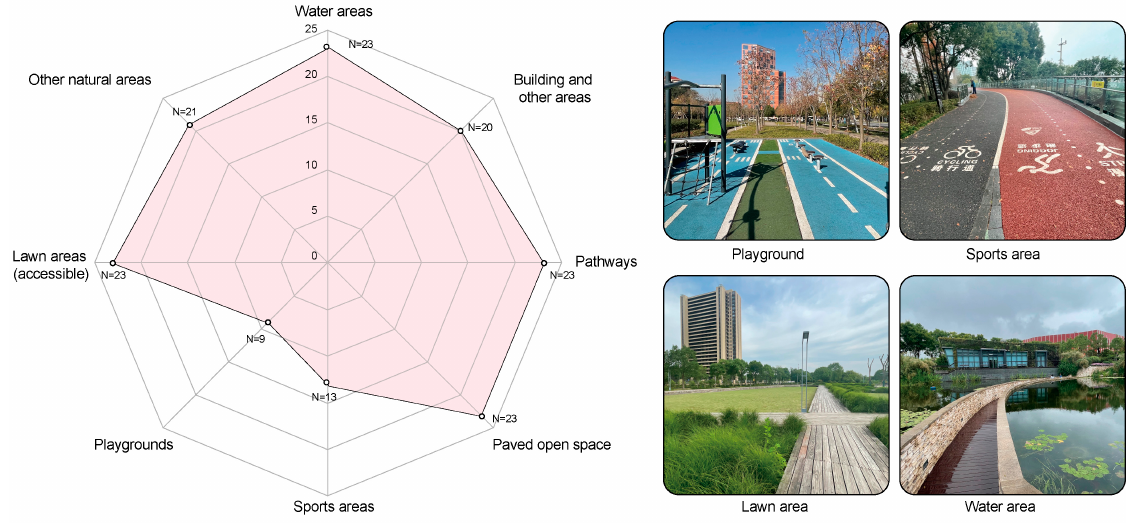
Figure 4. The configurations of park facilities.